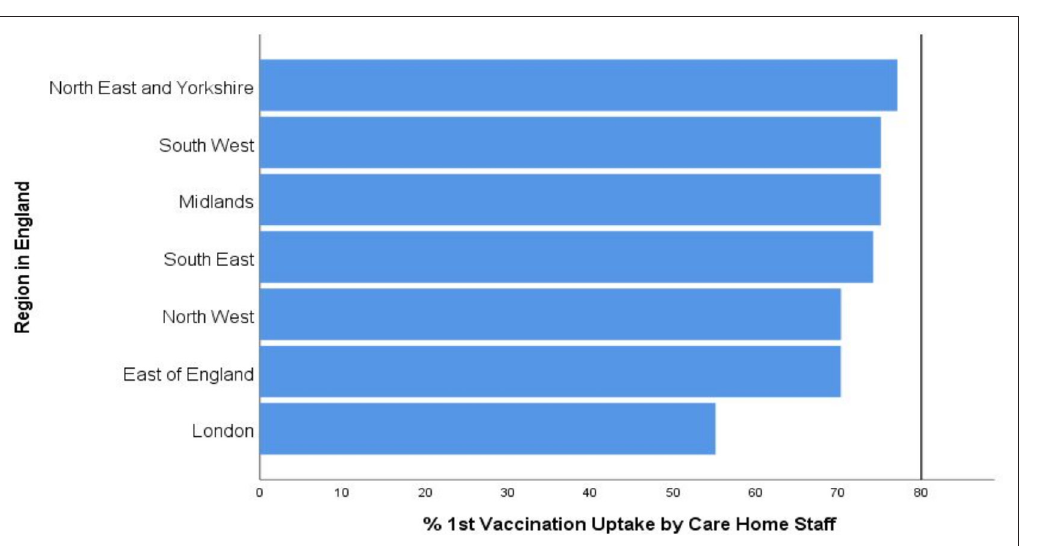
Figure 1 Percentage first vaccination uptake in care home staff by region in England immediately preceding the implementation of Roadmap out of COVID-19 Lockdown . Recommended vaccine uptake rate (80%) denoted by reference line